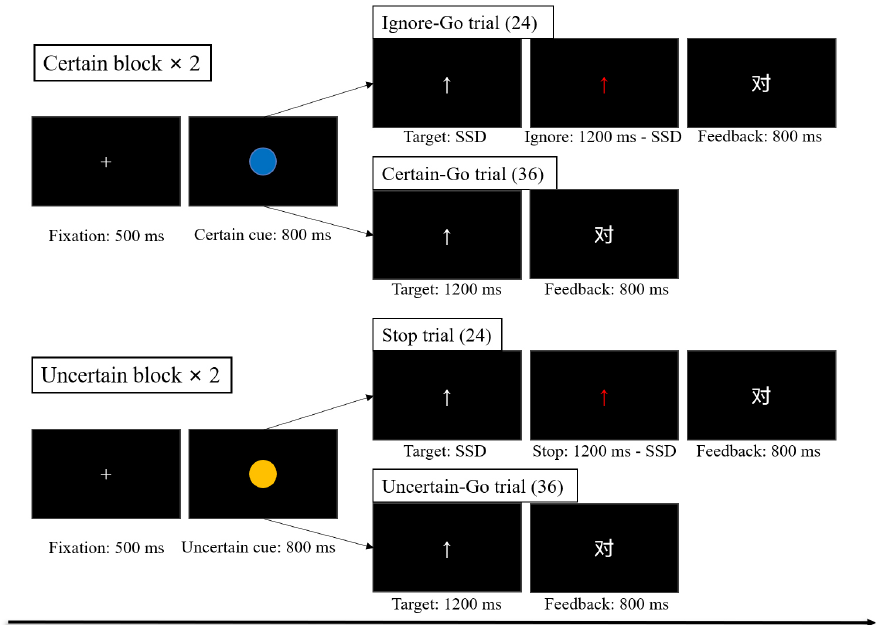
Figure 1. Illustration of the C-SST design. Both certain and uncertain blocks contained red arrows as the “Stop” signal in 40% of the trials. Note: SSD = the stop-signal delay. The feedback screen shows an example of a Chinese character that means